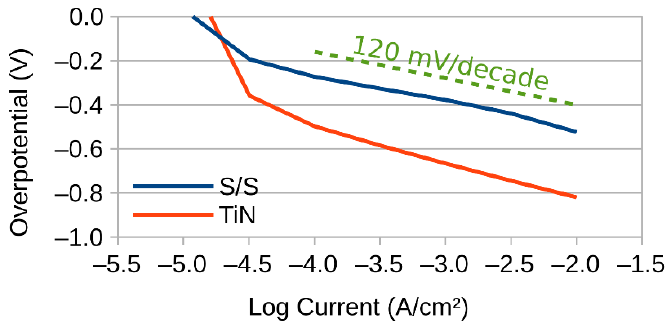
Figure 2. Tafel plots for stainless-steel and TiN before ageing.